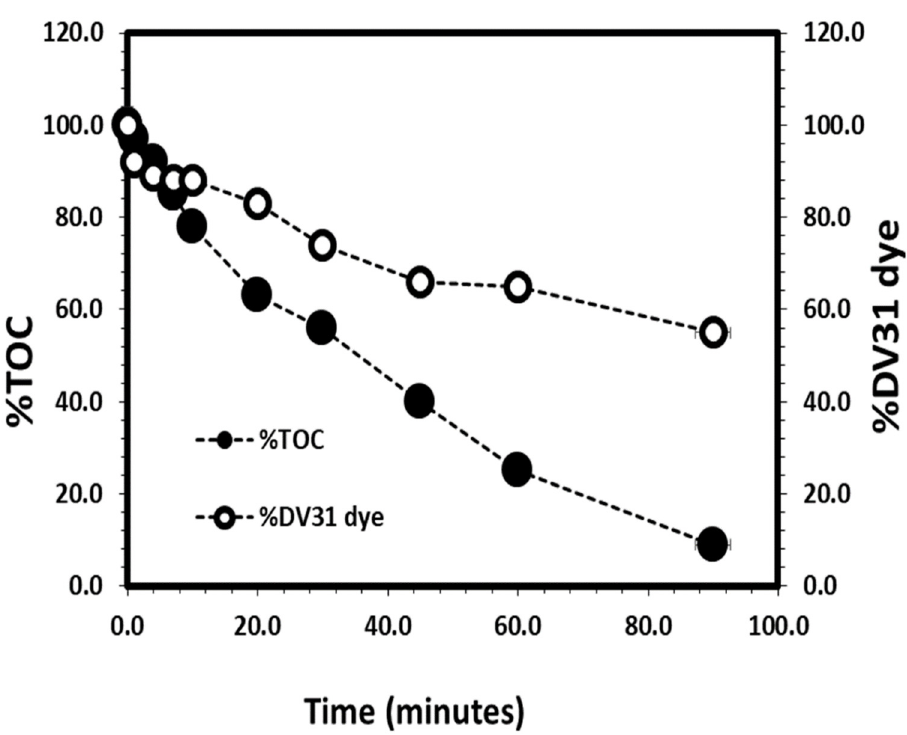
Figure 15. Variation of the %DV31 dye and %TOC in water with time for the removal of DV31 dye by CuO NPs from aqueous solution. (Experimental conditions: DV31 concentration 25 mg/L; 2 mL H 2 O 2 ; sample volume 400 mL; 40.0 mg CuO NPs; pH 8.6 and temperature at 25 °C).